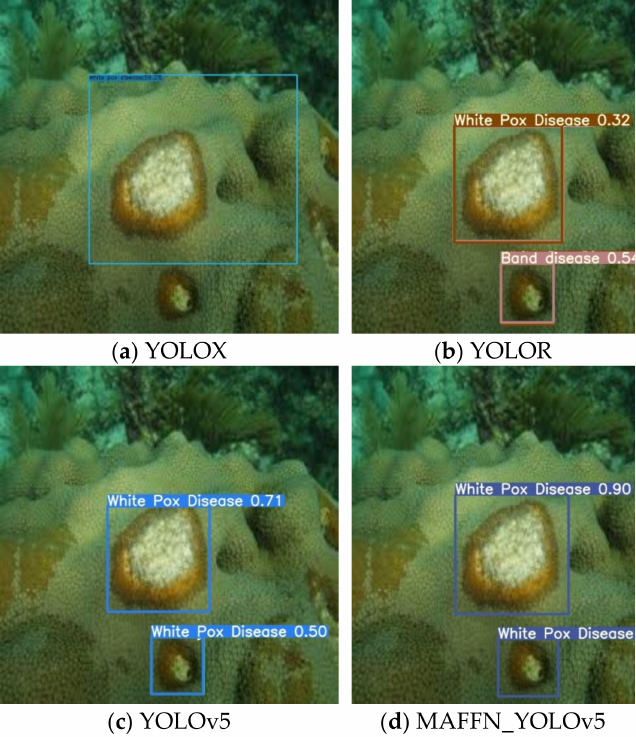
Figure 26. White pox disease detection. Further, the YOLOX model did not recognize another white pox diseased